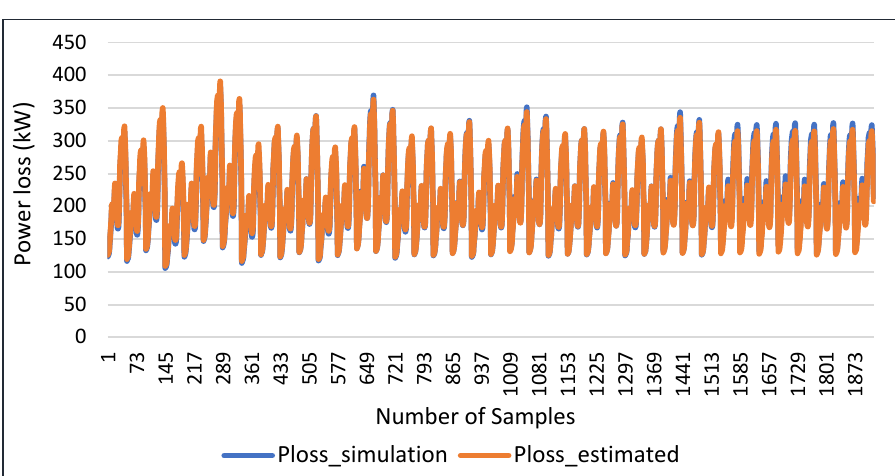
Figure 10. Active power loss obtained for case 2 for function 2.